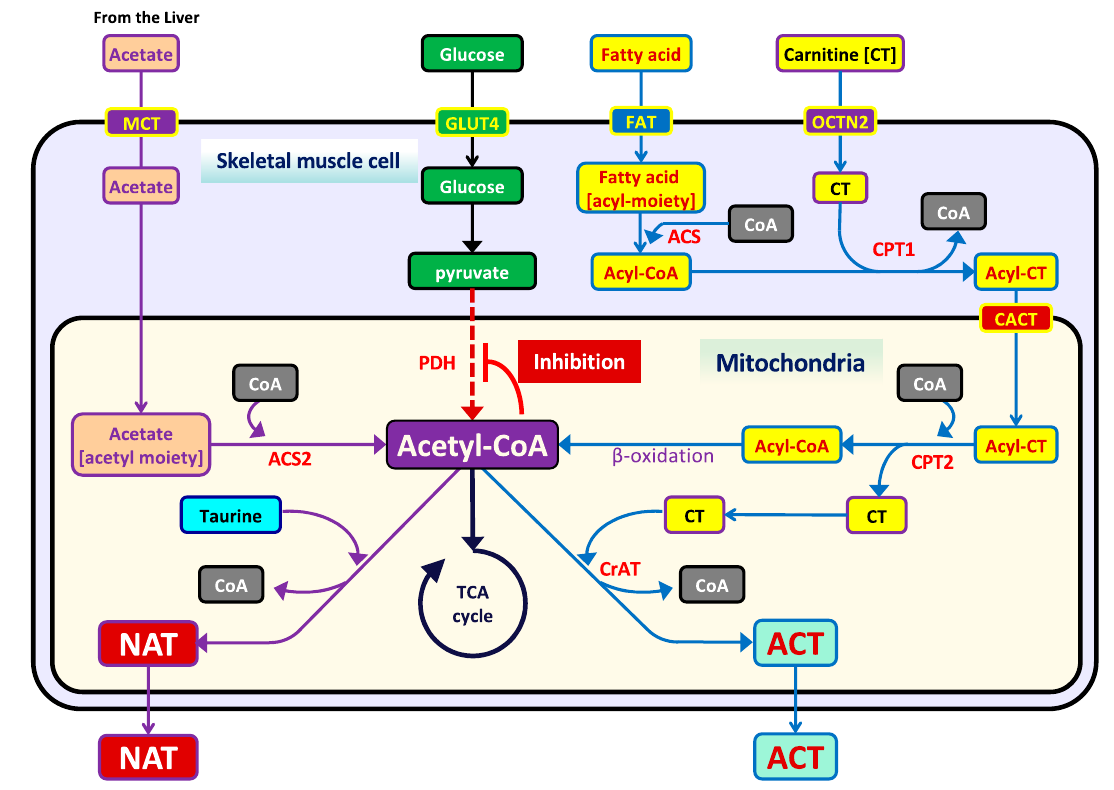
Figure 1. The preventive mechanisms for acetyl-CoA accumulation in the mitochondria through the acetylation of taurine and carnitine. An excess accumulation of mitochondrial acetyl-CoA metabolized from fatty acid and acetate would cause the metabolic stagnation of the glycolytic pathway as negative feedback through allosteric inhibition of PDH. To prevent the accumulation of mitochondrial acetyl-CoA, taurine and carnitine play buffering roles on the acetyl moiety of mitochondrial acetyl-CoA. Consequently, ACT and NAT are produced from fatty acids and acetate, respectively, and then excreted to extracellular fluids. Abbreviations: ACT; acetylcarnitine, ACS; acyl-CoA synthetase, ACS2; acetyl-CoA synthetase 2, CACT; carnitine acylcarnitine translocase, CPT; carnitine palmitoyl transferase, CrAT; carnitine acetyltransferase, CT; carnitine, GLUT4; glucose transporter 4, MCT; monocarboxylate transporter, NAT; N -acetyltaurine, OCTN2; organic anion transporter 2, PDH; pyruvate dehydrogenase.